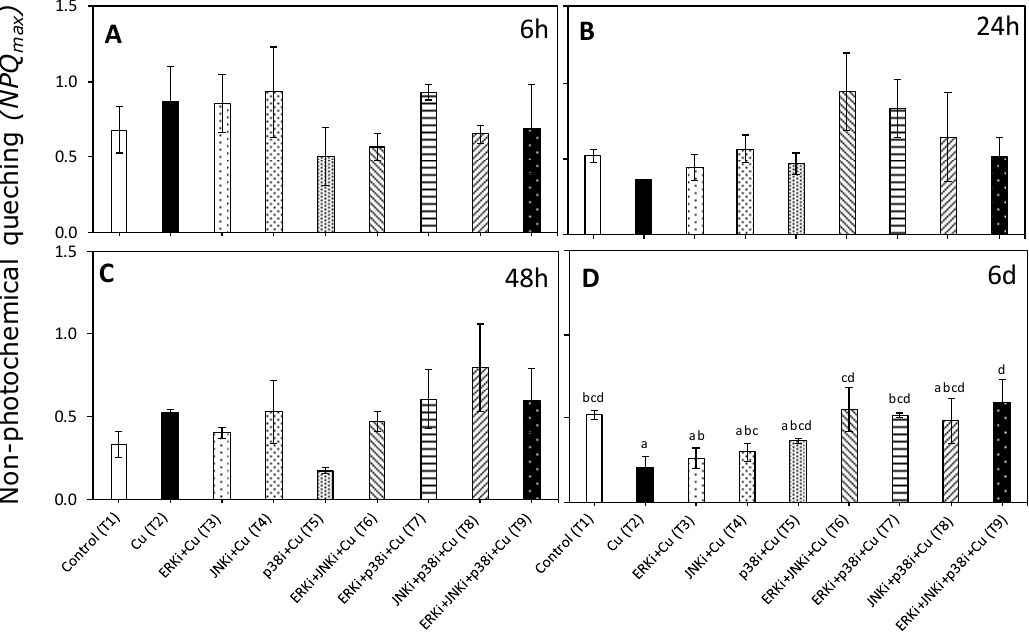
Figure 6. Maximal non-photochemical quenching ( NPQ max ) in U. compressa under copper and/or exposure to MAPK inhibitors. Treatments: T1—control only with seawater; T2—copper only exposure as 10 µM CuSO 4 (Cu); T3—copper + 5 µM MAPK Extracellular Signal Regulated Kinase (ERK) inhibitor PD98059 (Cu + ERKi); T4—copper + 5 µM MAPK c-Jun N -terminal Kinase (JNK) inhibitor SP600125 (Cu + JNKi); T5—copper + MAPK Cytokinin Specific Binding Protein (p38) inhibitor SB203580 (Cu + p38i); T6—Cu + ERKi + JNKi; T7—Cu + ERKi + p38i; T8—Cu + p38i + JNKi; and T9—Cu + ERKi + JNKi + p38i. Samples were analyzed after ( A ) 6 h, ( B ) 24 h, ( C ) 48 h, and ( D ) 6 d of treatment. Different letters within each graph represent significant differences at the 95% confidence interval ( p < 0.05). No significant differences were detected at experimental times of 6, 24, and 48 h ( p > 0.05). Plots are represented as mean ± SE ( n = 3).